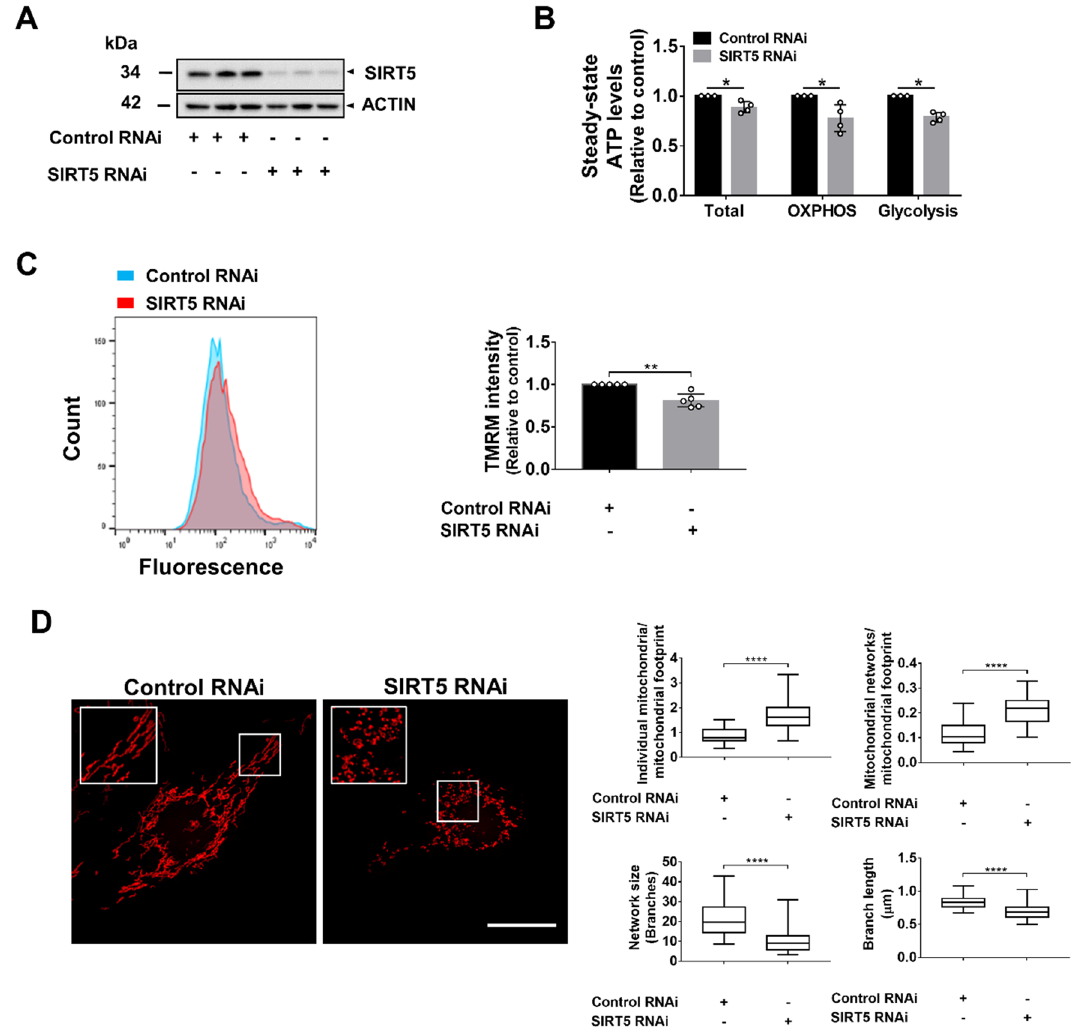
Figure 2. SIRT5 -knockdown impairs cellular energy metabolism and induces mitochondrial fragmentation. SIRT5 -knockdown by RNAi was carried out in hPTECs. Non-targeting siRNA served as control. All experiments were performed 72 h after siRNA transfection. ( A ) WB showing SIRT5 protein levels. Whole WB shown in supplementary file (Supplementary Fig. S8b). ( B ) Bar graph shows ATP levels. hPTECs (control and SIRT5 RNAi) were analyzed without inhibitor treatment to determine total ATP levels (glycolytic + mitochondrial ATP), after treatment with 2-deoxyglucose to inhibit glycolysis (mitochondrial ATP; OXPHOS) or after treatment with oligomycin A to inhibit mitochondrial ATP synthase (glycolytic ATP; Glycolysis). ATP levels were normalized to cell number as measured by DNA quantification. Data are from four independent experiments with n = 5–6 technical replicates/group. ( C ) Bar graph showing TMRM fluorescent intensity. hPTECs (control and SIRT5 RNAi) were incubated with TMRM (25 nM), a fluorescent dye which accumulates in mitochondria based on the ΔΨ M and fluorescent intensities were determined by flow cytometry. Background fluorescence was assessed by FCCP treatment (10 µM) prior to TMRM incubation and fluorescence intensities were subtracted from the TMRM fluorescence intensities. Data are from five independent experiments with n = 2 technical replicates/group. Data are median ± IQR. To determine statistical significance a Mann–Whitney U test was applied. *p < 0.05 and **p < 0.01. ( D ) Cells were stained with Mitotracker Red CMXRos (100 nM) and imaged by confocal microscopy. Scale bar: 20 µm. ( B ) Mitochondrial morphology was quantitatively assessed using the Mitochondrial Network Analysis (MiNA) toolset (ImageJ). The number of (i) individual mitochondria and (ii) mitochondrial networks per cell were quantified and normalized to the mitochondrial footprint; (iii) mean network size (number of branches) and the mean branch length (µm) were determined. Forty-two control RNAi-treated and 51 SIRT5 RNAi-treated cells from three independent experiments were analyzed. Box and whisker plots display median interquartile range and minimum and maximum values. Mann–Whitney U test was used to determine statistical significance. ****p <